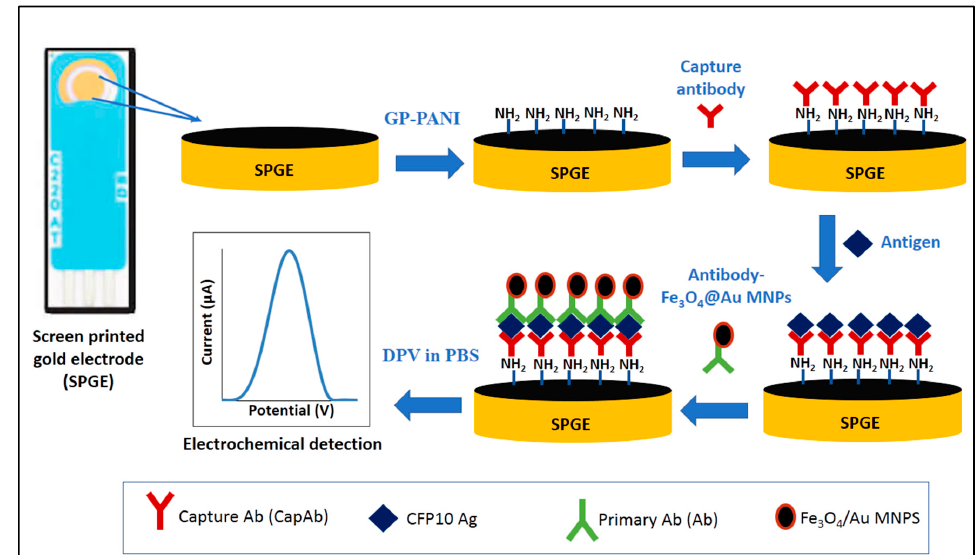
Figure 1. Schematic diagram of the fabrication process of GP/PANI-modified SPGE in sandwich immunoassay format.